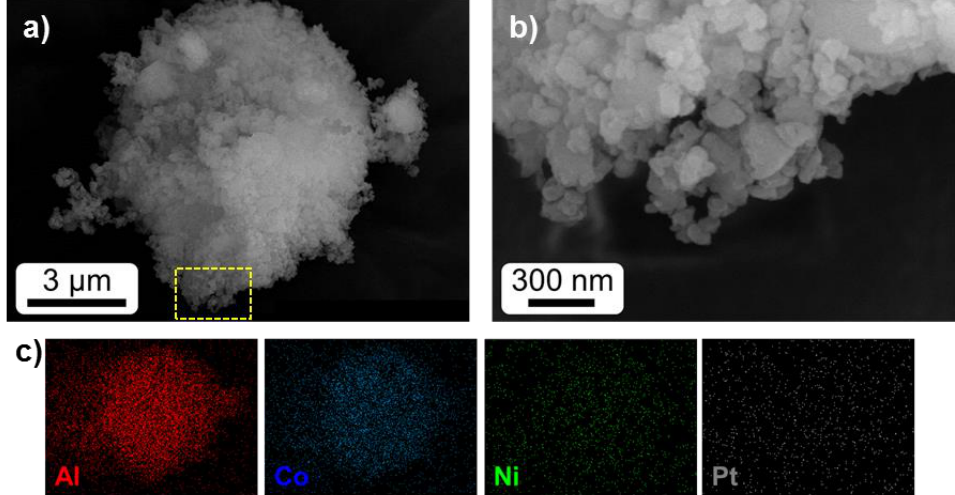
Figure 2. ( a ) FE-SEM micrograph of the Pt,Ni / CoAl 2 O 4 catalyst, ( b ) HR-SEM magnification of the area marked in yellow in (a), and ( c ) EDX elemental mapping obtained in (a).